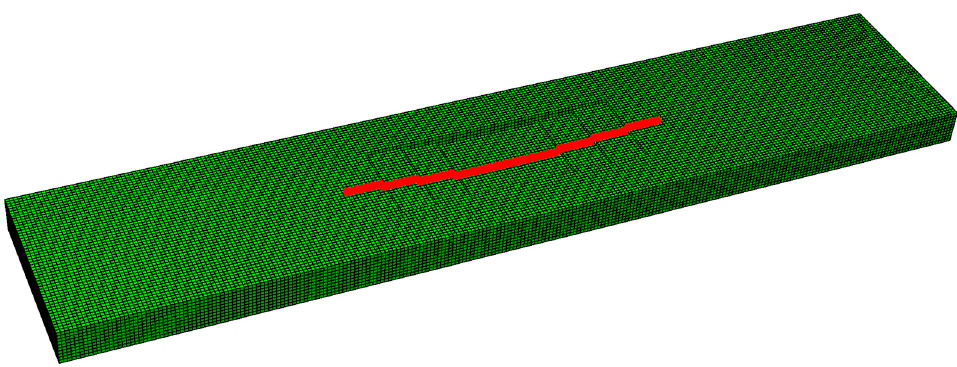
Figure 14. The red line marks the location of stress extraction.